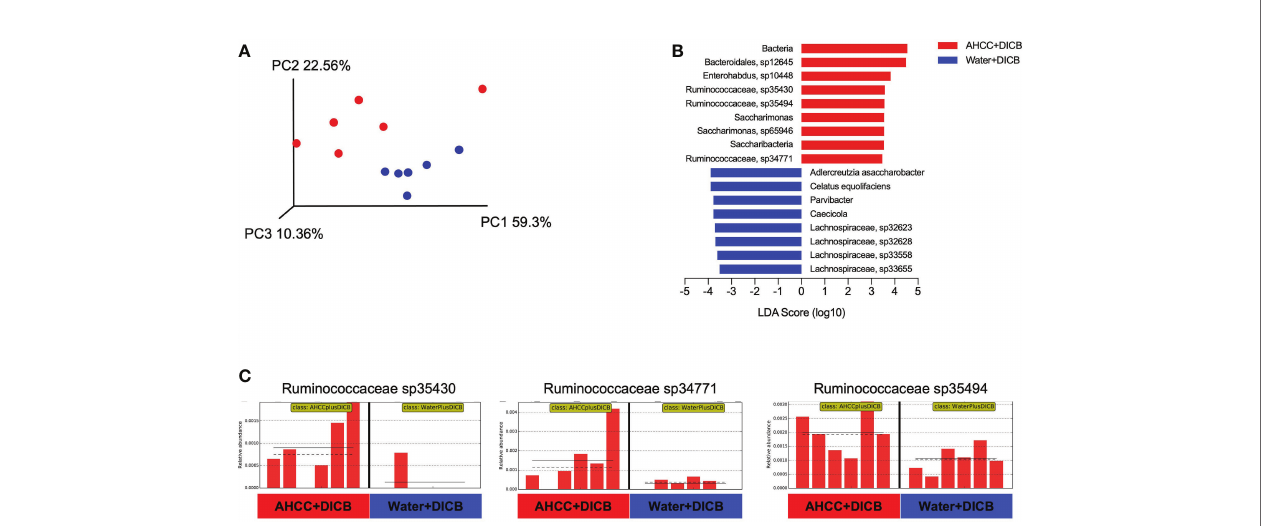
FIGURE 3 | AHCC ® alters the gut microbiome in MC38 tumor-bearing mice treated with dual PD-1/CTLA-4 blockade. Gut microbiome analysis was done in MC38 tumor-bearing mice treated with AHCC ® or water in the presence of DICB therapy by sequencing bacterial 16s rRNA genes in the feces collected on the sacri fi cing day. (A) Principal coordinate analysis (PCoA) plot of bacterial b -diversity based on Unweighted Unifrac Plots of unique amplicon sequence variants (ASV) (n = 6/group). (B) A linear discriminant analysis (LDA) combined with effect size measurements (LEfSe) showing signi fi cant bacterial differences in the two groups (n = 6/group). Logarithmic LDA score threshold > 3.0 and P value of < 0.05 were considered signi fi cant. (C) Bar graphs showing the abundance distribution pro fi le of indicated Ruminococcaceae species in the two groups (n = 6/group). The horizontal and dotted lines in the panels indicate the group mean and median,